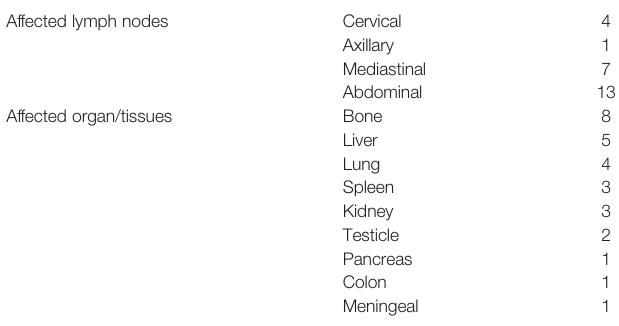
TABLE 2 | Summary of extra-adrenal in fi